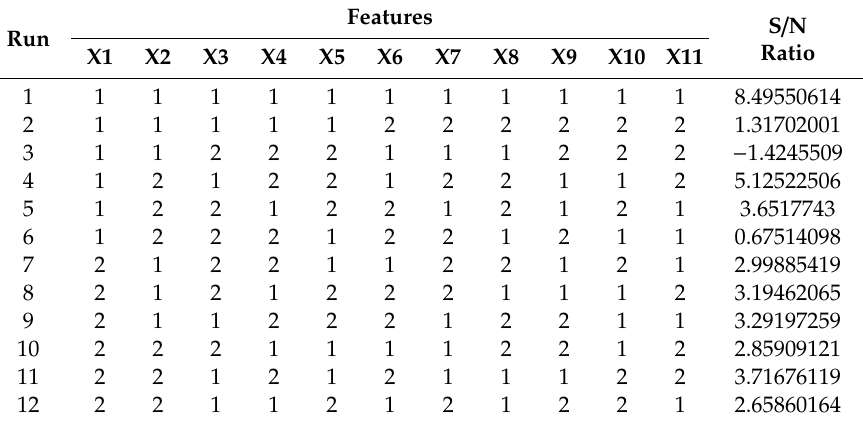
Table 10. L 12 (2 11 ) OA for the ACLR conditions.